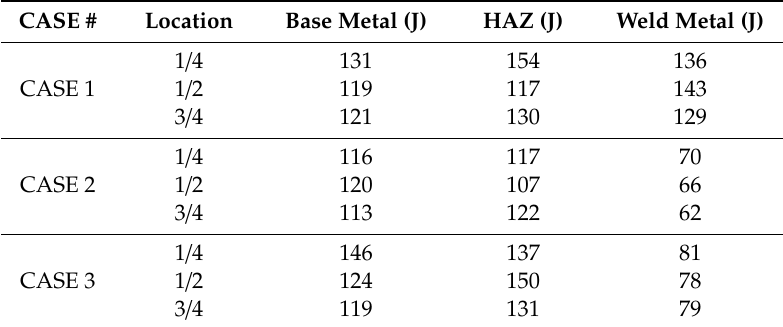
Table 8. Cryogenic impact test results for each laser welding case.